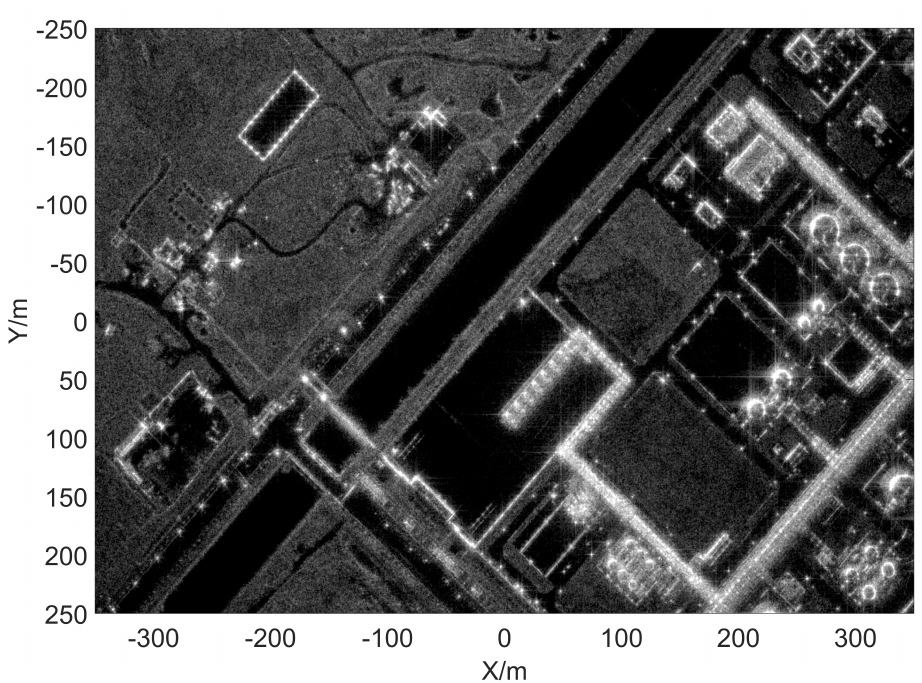
Figure 4. 360 ◦ coherent complex image of the C-band circular